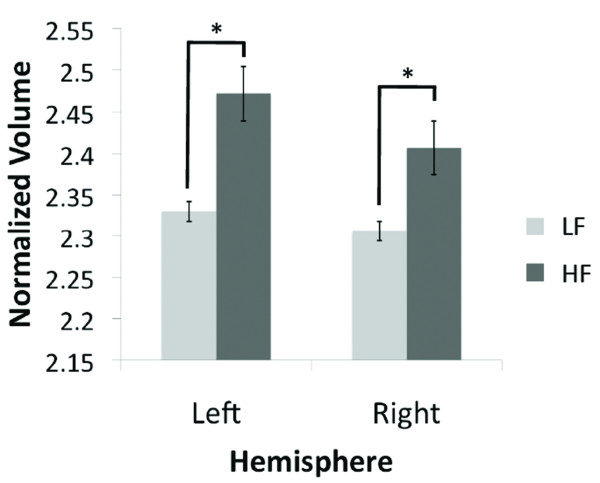
Volumetric Changes of the Caudate. The plots show the significant caudate volumetric differences in the high vs. low frequency migraine subjects (left: p < 0.025 and right: p < 0.006). The volumes have been normalized to the total intracranial volume to scale for the brain volume for each subject. Bar heights represent the mean value for each volumetric measurement. Error bars represent the 95% confidence interval of the mean. * denotes significance.